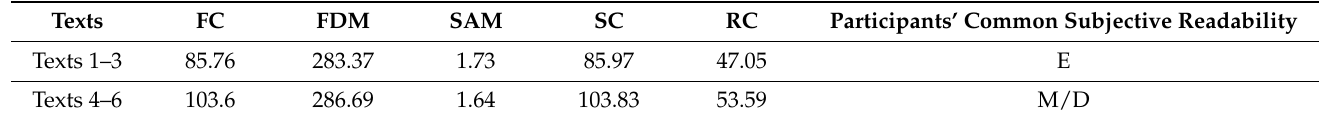
Table 9. Average text